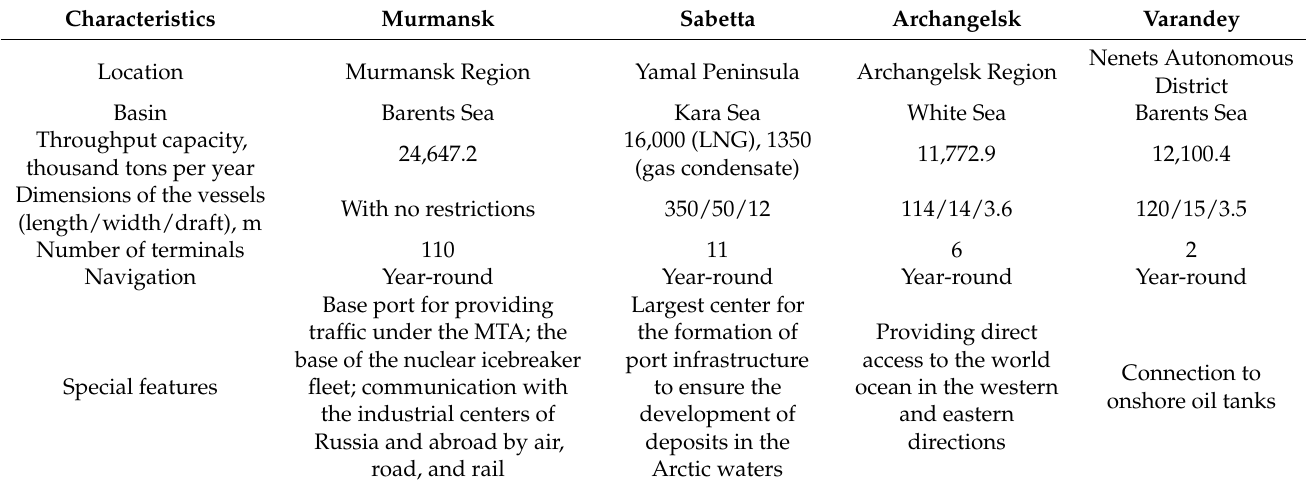
Table 5. Major port of the Russian Arctic zone for transshipment of oil and gas